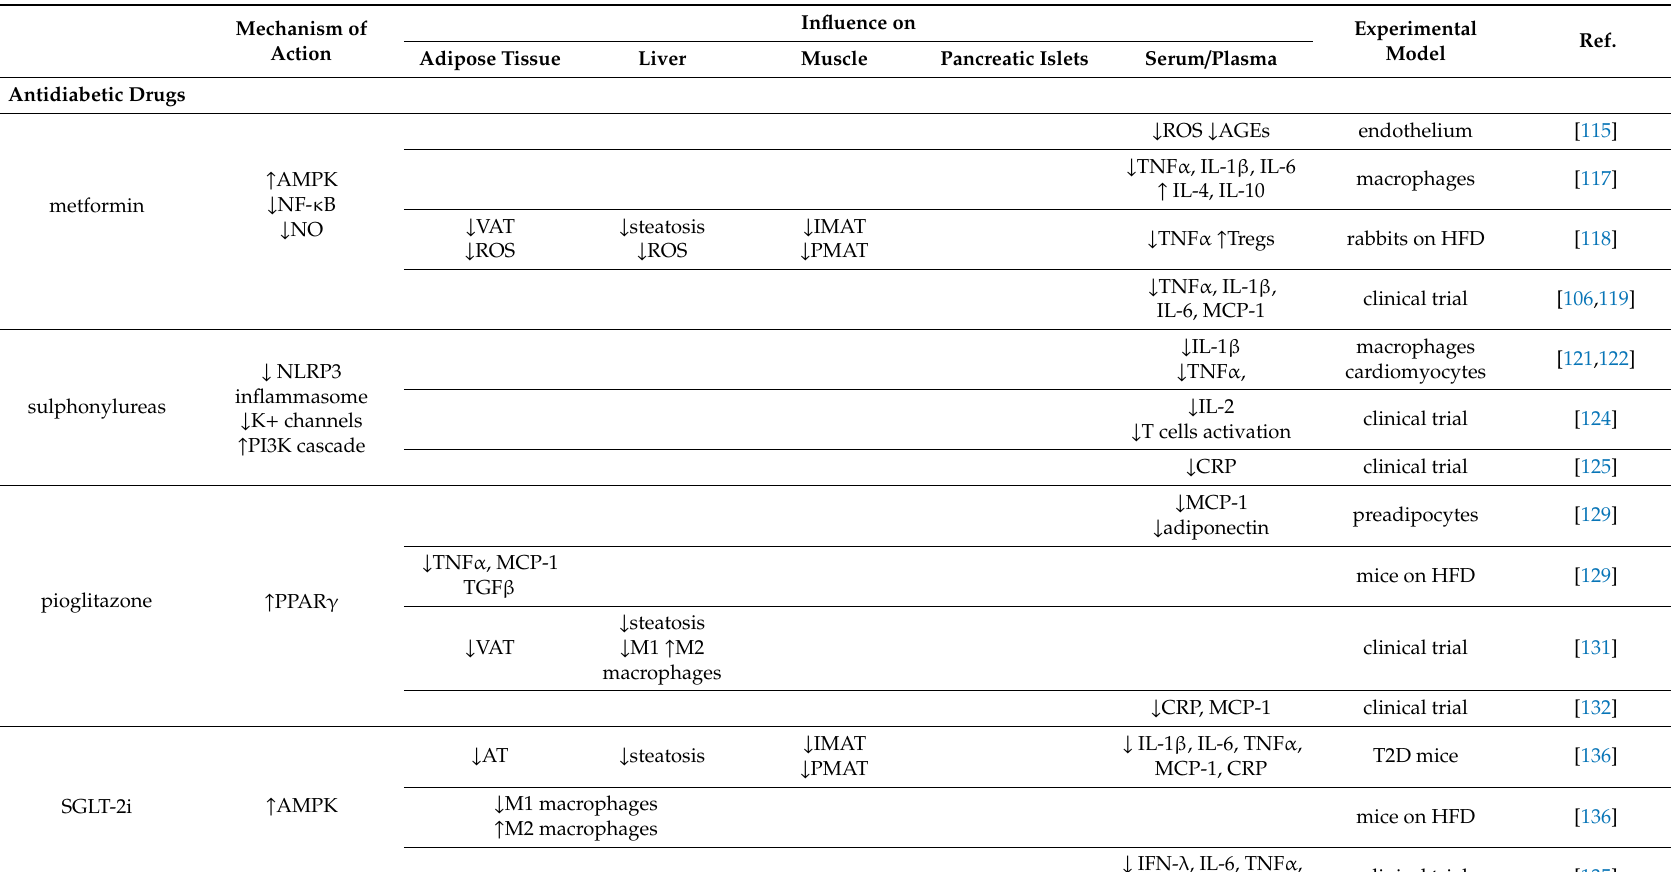
Table 2. Summary of the available non-invasive therapies targeting metaflammation in type 2